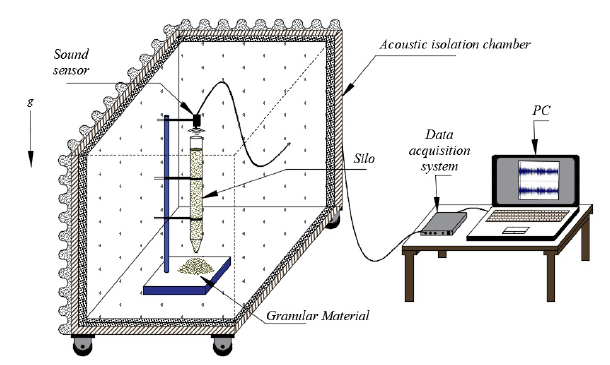
Figure 6. Disposition scheme of the